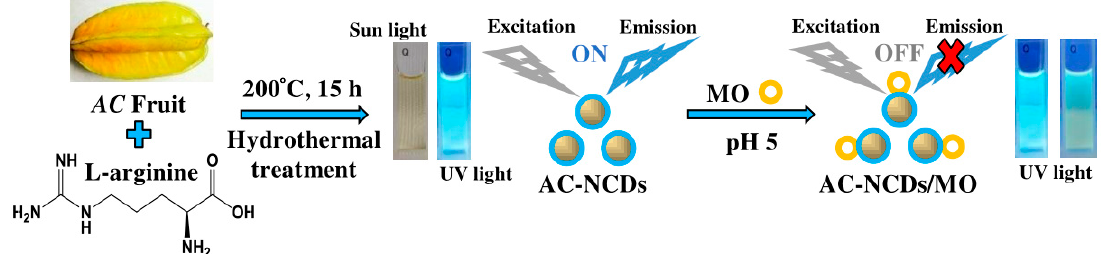
Figure 1. A schematic representation of Averrhoa carambola (AC)-nitrogen-doped carbon dots (NCDs) synthesis and application as a fluorescent probe for methyl orange (MO).